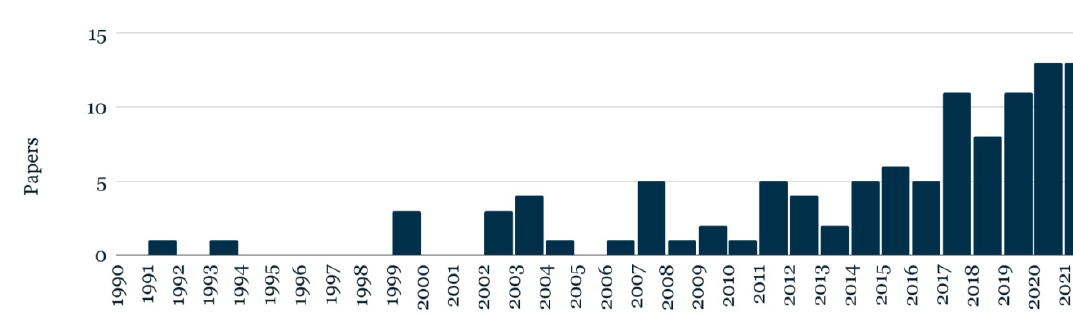
Figure 2. Histogram of publication years.